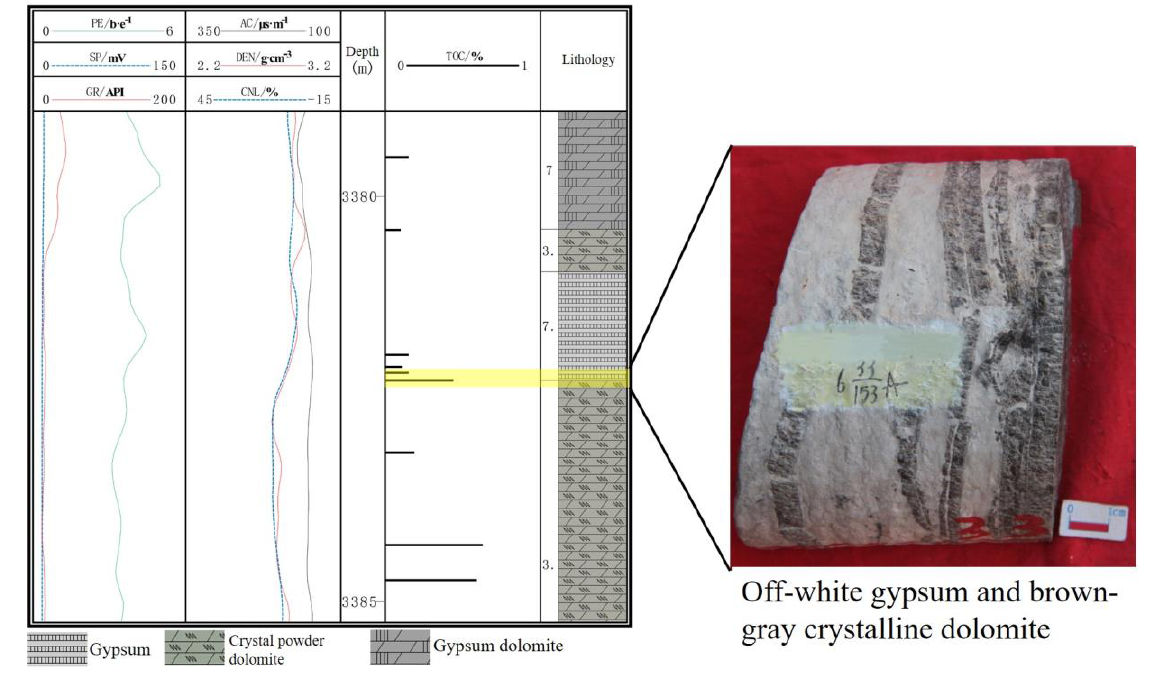
Figure 3. Schematic diagram of core logging.